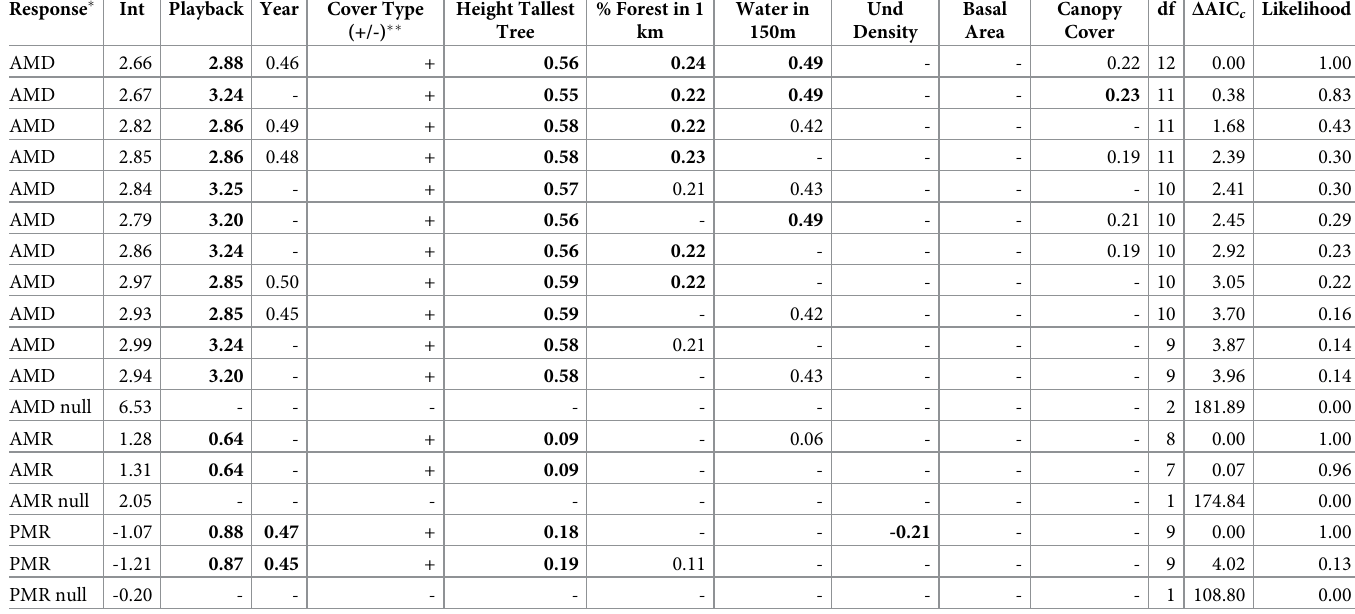
Table 2. Supported diversity and richness models and null models for all migrants and priority migrants. Models were selected by likelihood value � 0.125 and the absence of uninformative parameters. Bolded coefficients indicate significance at P � 0.05. Response � Int Playback